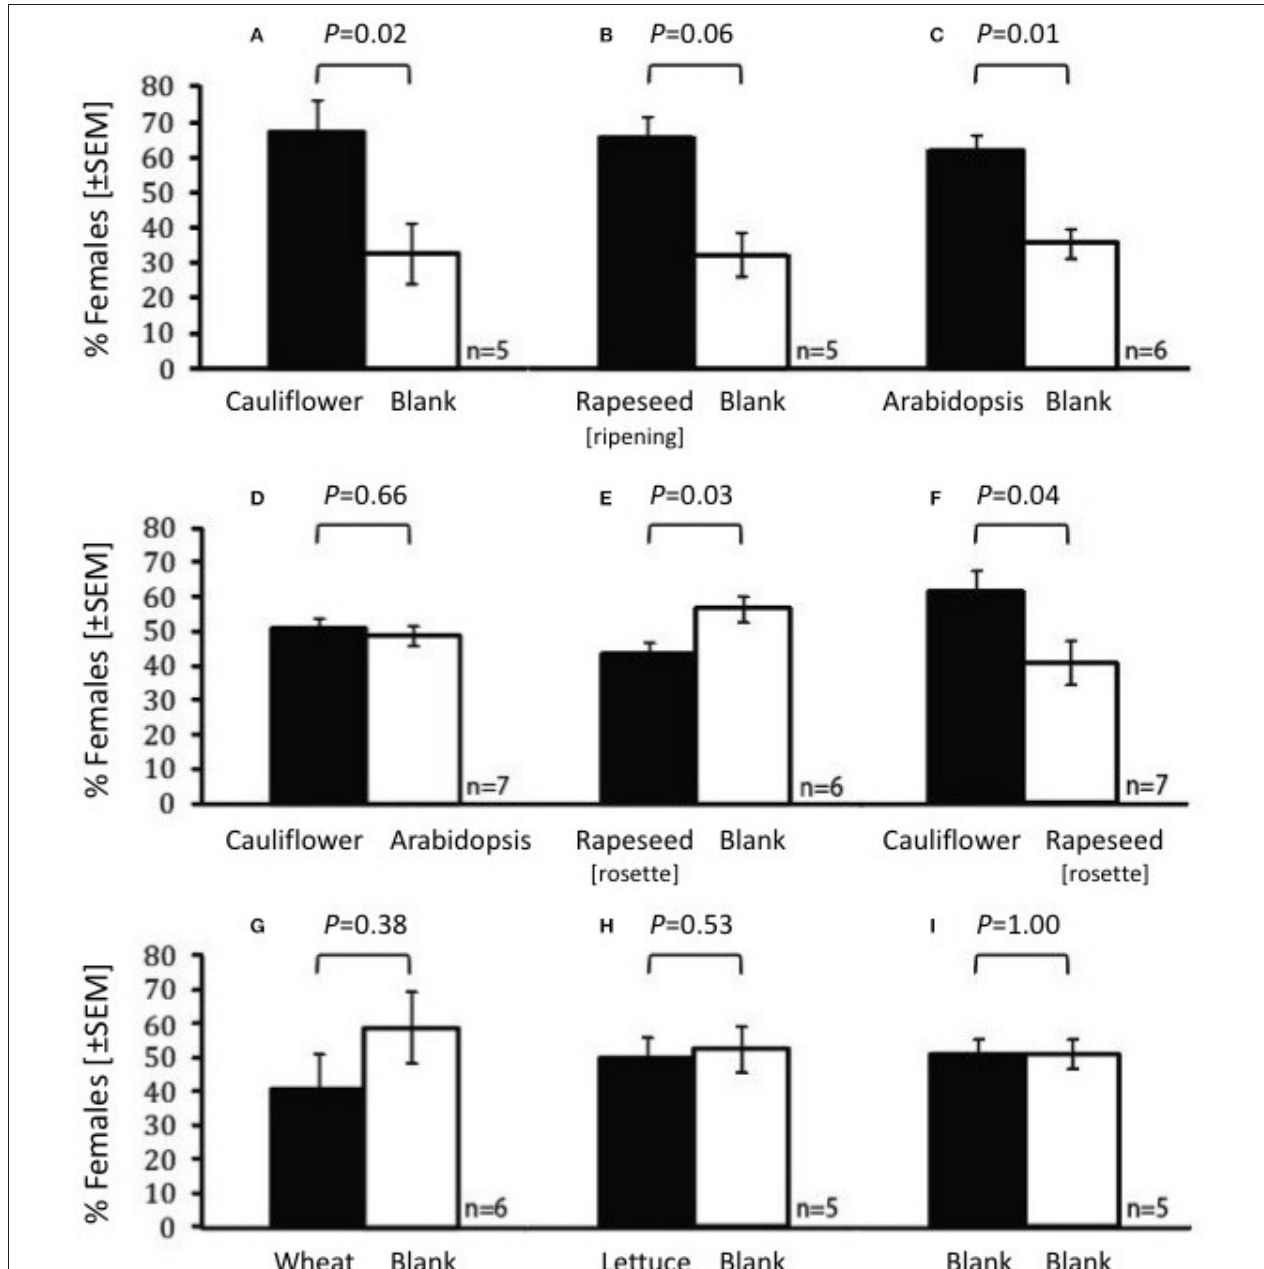
FIGURE 3 | Olfactory preference of female Contarinia nasturtii in the olfactometer when the following are compared: (A) cauliflower vs. blank, (B) rapeseed (ripening) vs. blank, (C) Arabidopsis thaliana vs. blank, (D) cauliflower vs. A. thaliana , (E) rapeseed (rosette) vs. blank, (F) cauliflower vs. rapeseed (rosette), (G) wheat vs. blank, (H) lettuce vs. blank and (I) blank vs. blank. Female attraction to the two odors was compared by Mann-Whitney test. P -values are displayed over each comparison. n = 5–7 per combination, each using a total of 94–107 females.